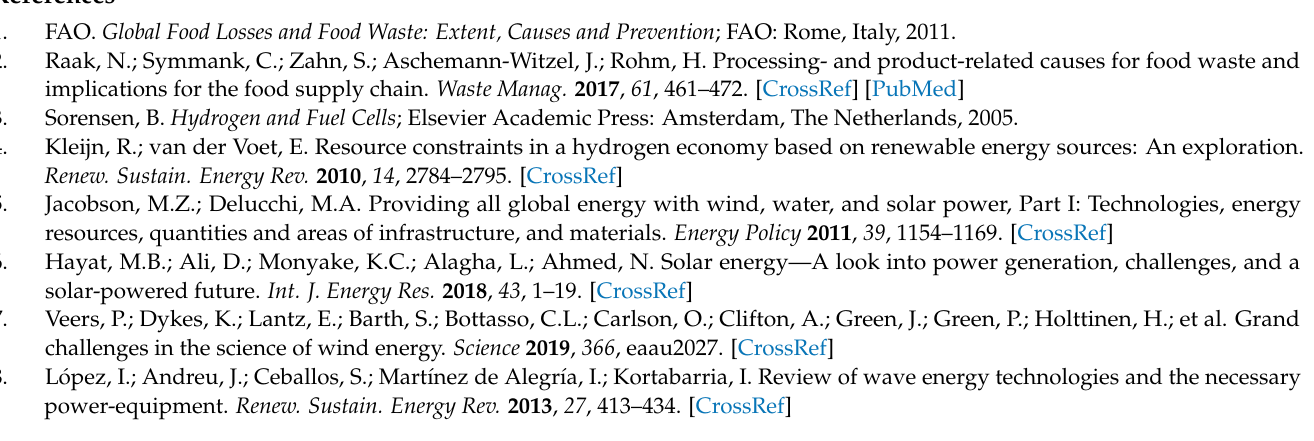
Figure 14. Framework of the benefits in the PSII panel.